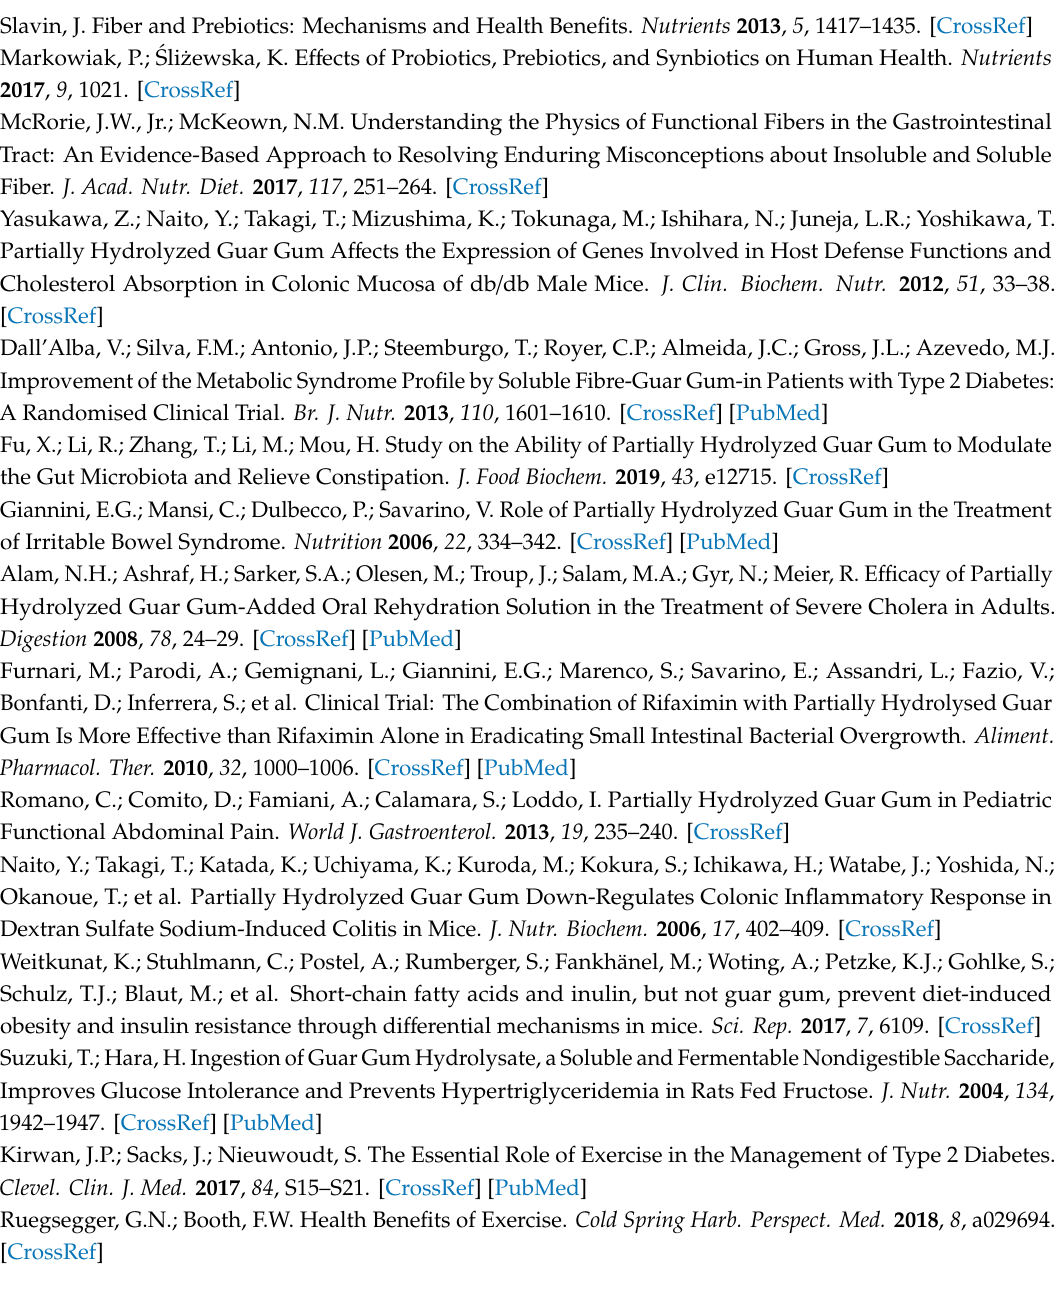
Figure S1: Schematic illustration of experimental design of this study, Figure S2: E ff ects of PHGG and wheel running on body mass (a) and food intake (b) in CD and HFD fed